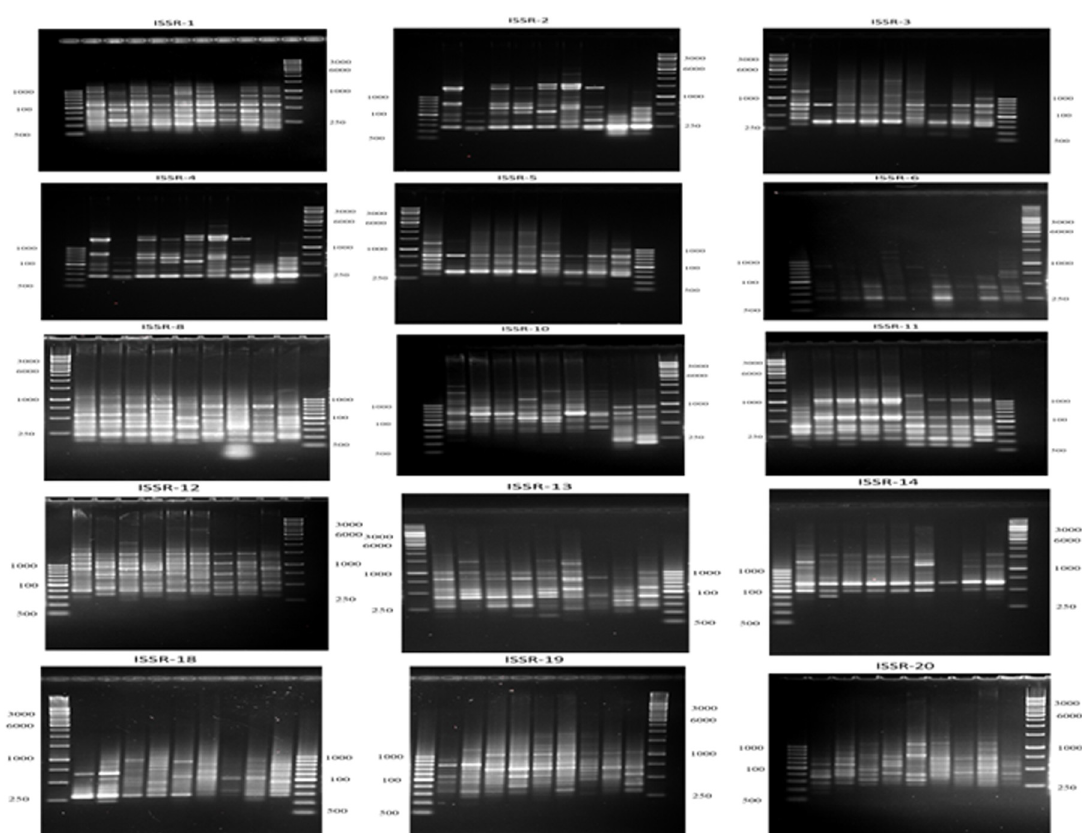
Fig 6. A representative agarose gel where PCR products of the 15 ISSR primers for the nine treatments.